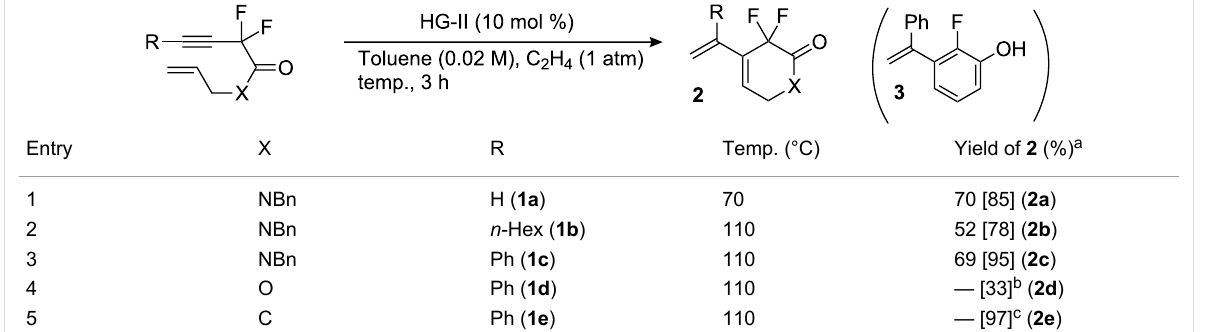
Table 2: Metathesis reaction of fluorinated 1,7-enyne carbonyl compounds.